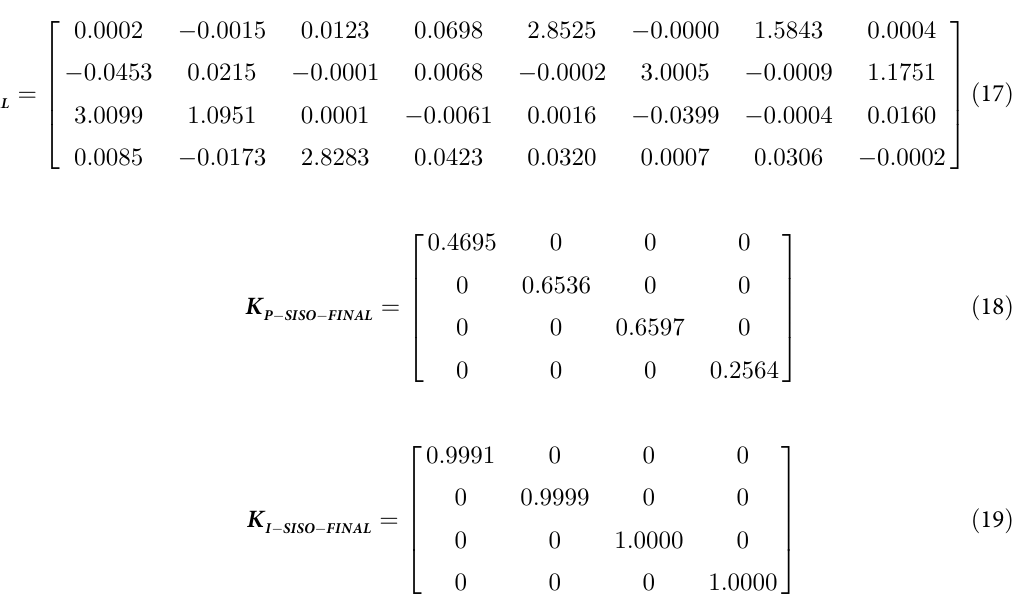
At the end of the tuning process the final values for K , K lows in (17), (18) and (19) respectively: